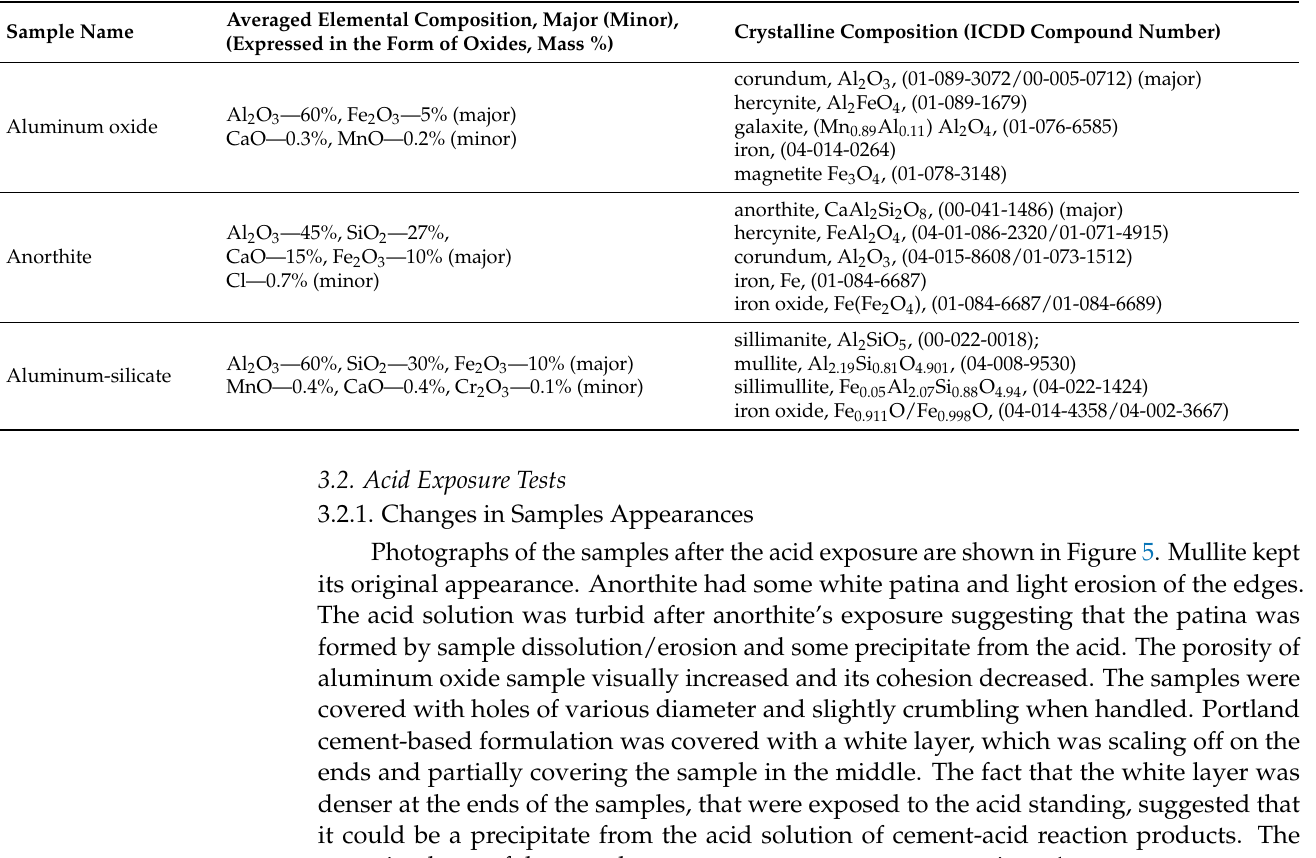
Figure 6. 3D images of mullite before (top row: ( a – c )) and after (bottom row: ( a’ – c’ )) the acid exposure for three different sites. The numbers indicate the depth of the sample features on 3D images. Both erosion and precipitation can be seen on anorthite samples after the acid exposure (Figure 7, images a’ and b’). The sample erosion resulted in a clear dark straight - line pattern, while precipitation created white patina on the sample surface. The depth of the surface features slightly decreased after the exposure due to the precipitation of the anorthite-acid reaction products on the surface of the samples. However, the integrity of the sample was intact. Figure 7. 3D images of anorthite before (top row: ( a , b )) and after (bottom row: ( a’ , b’ )) the acid exposure for two different sites. The numbers indicate the depth of the sample features on 3D images.